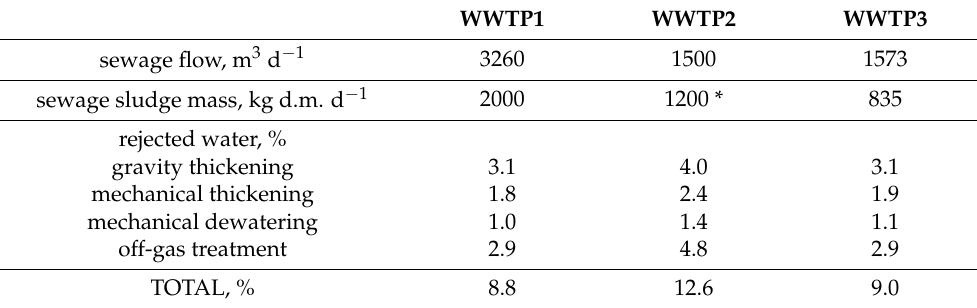
Table 4. Quantity of the rejected water in main stream of sewage (design